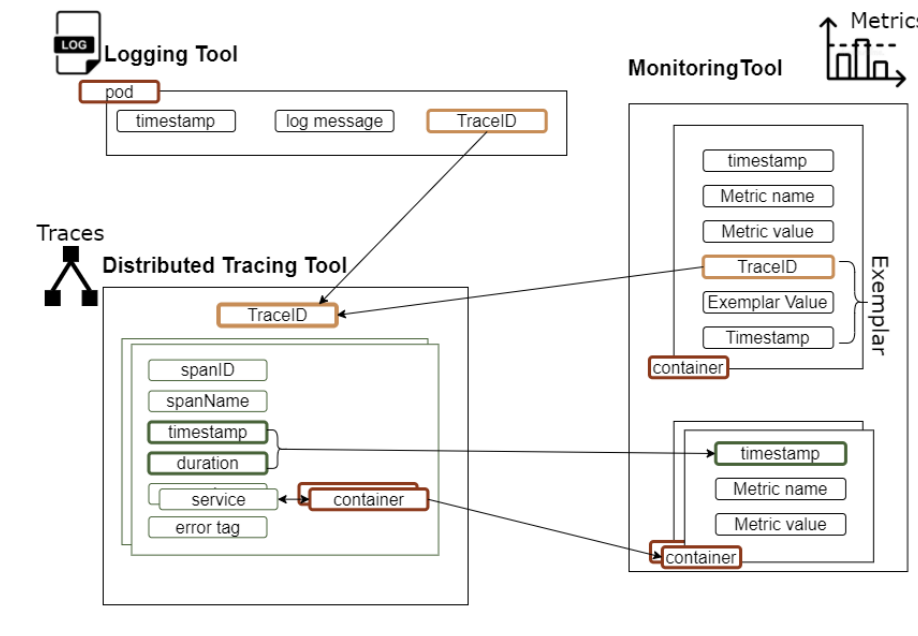
Figure 4. Data fusion